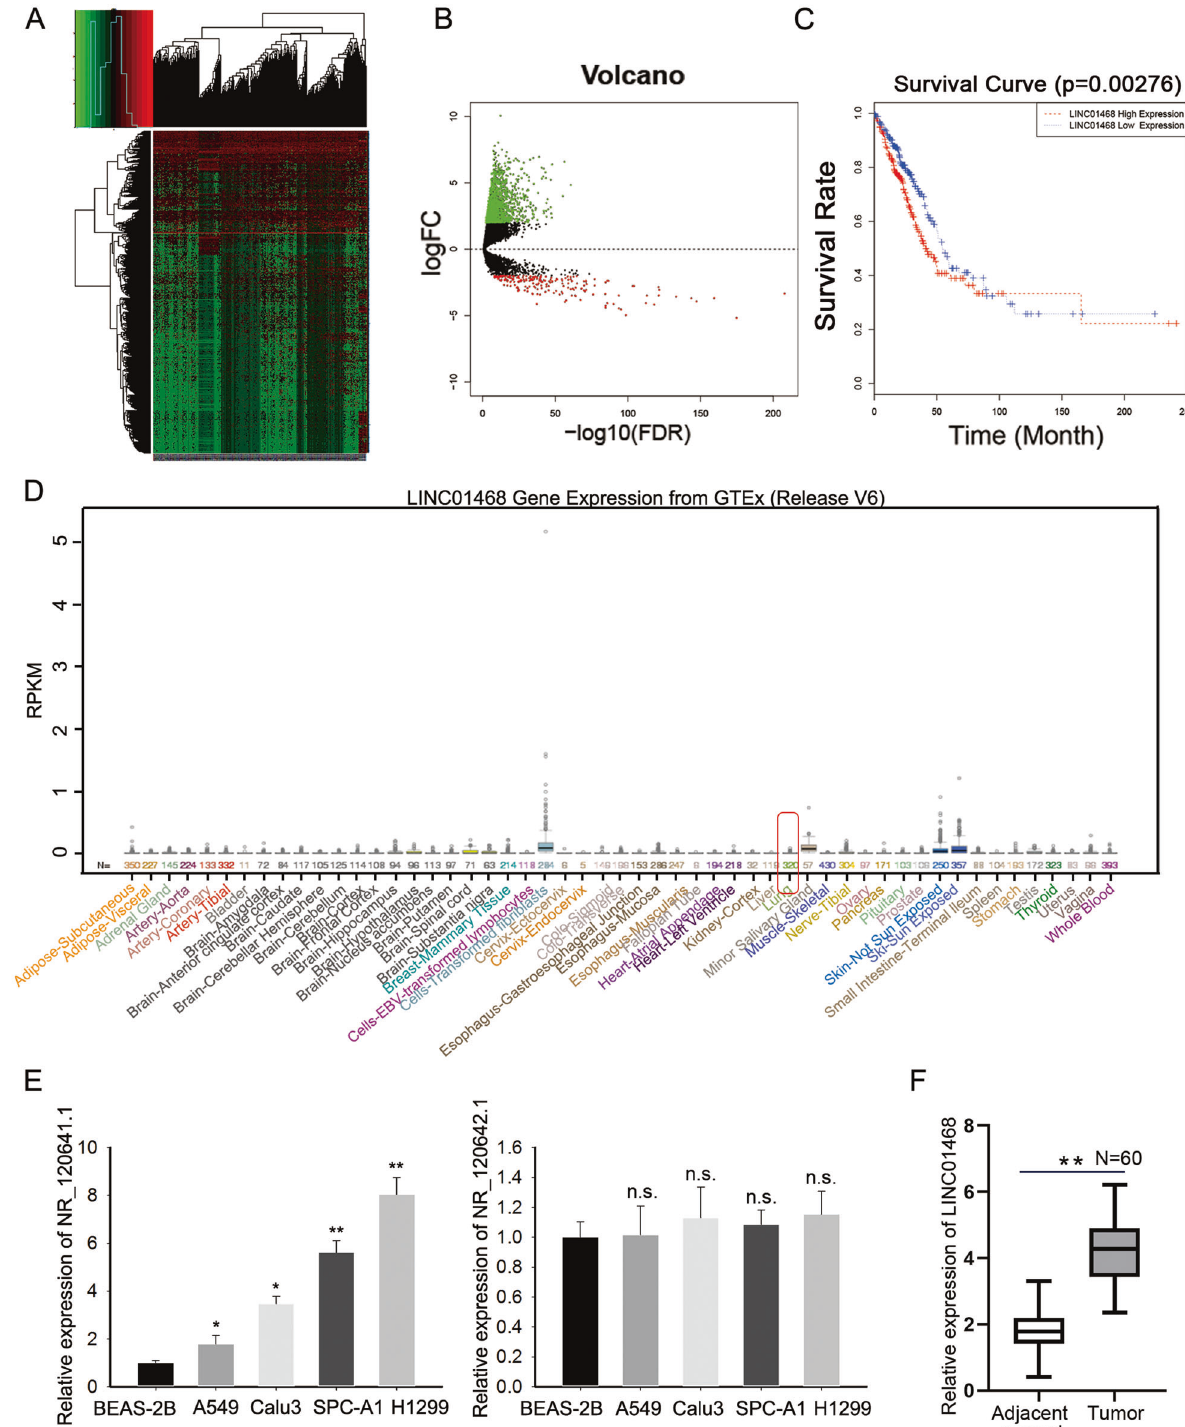
Fig. 1 LINC01468 is upregulated in LUAD tissues and cell lines. A A heat map was generated to show the lncRNA pro fi les in TCGA lung cancer samples. B A volcano plot recorded the differentially expressed lncRNAs (fold-change > 2.0). C Survival curve was plotted to analyze the overall survival of lung cancer patients with high or low LINC01468 expression. D LINC01468 expression pro fi le in normal tissues was obtained from UCSC. E The expression level of different LINC01468 transcripts in LUAD cell lines and normal cell line BEAS-2B was examined by RT- qPCR. F LINC01468 expression was examined in 60 pairs of LUAD tissues and adjacent normal tissues by RT-qPCR. Results were exhibited as the mean ± SD on the basis of three independent experiments. * p < 0.05, ** p < 0.01 indicated the statistical signi fi cance of experiments data. n.s.: no signi fi